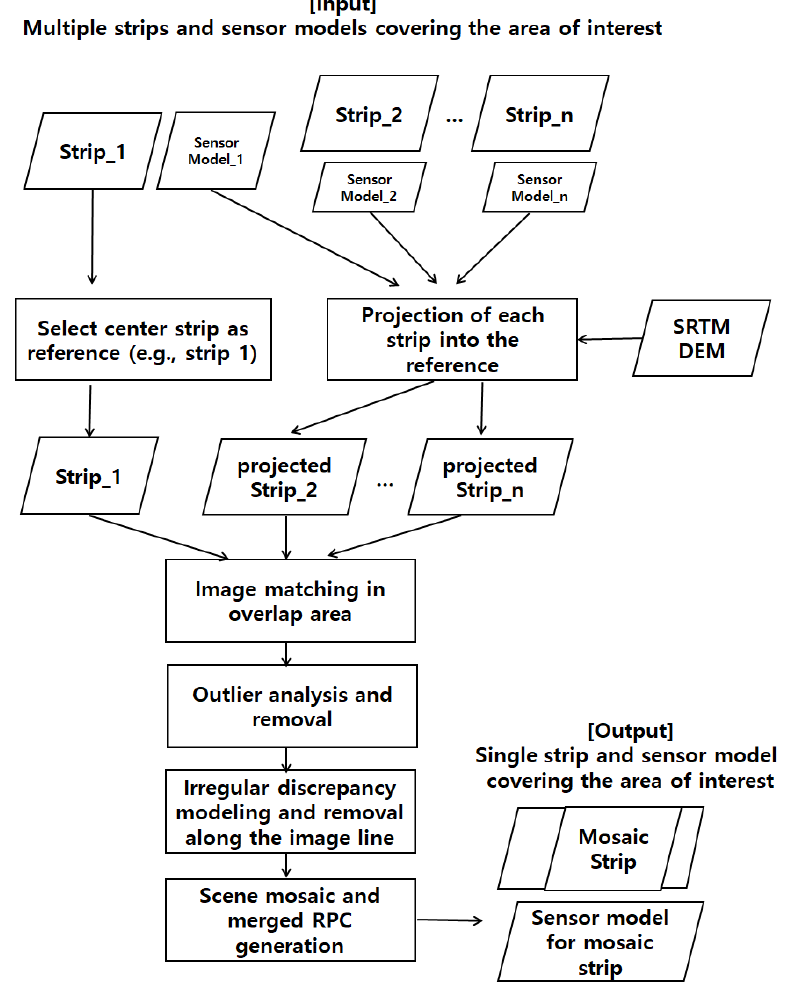
Figure 2. Flowchart of the proposed method for the sensor-level mosaic.